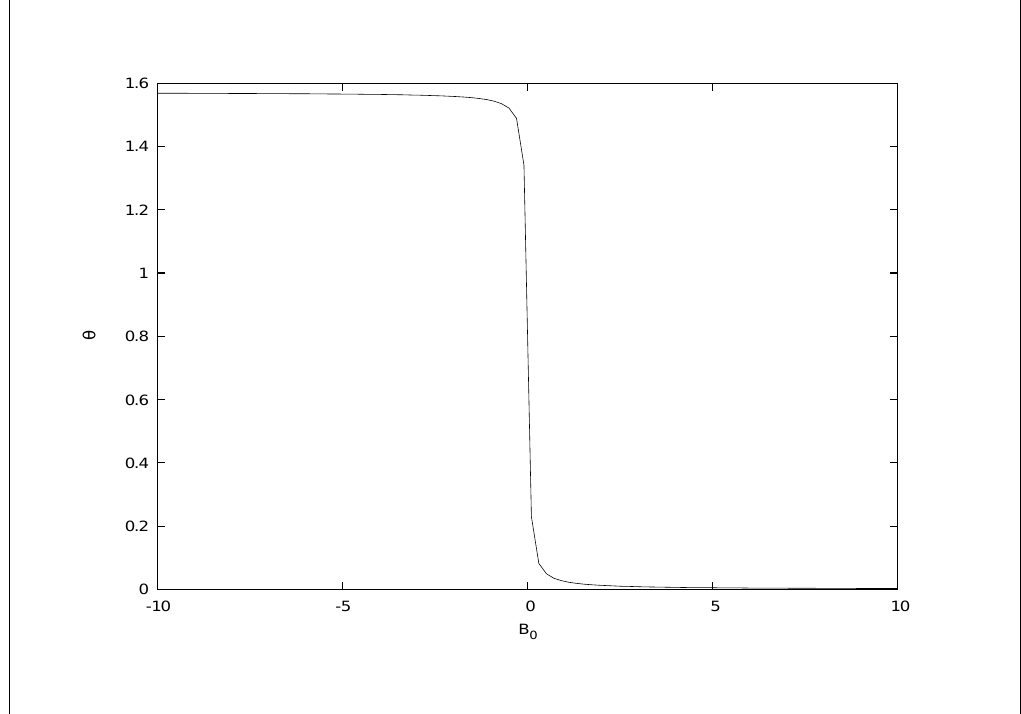
Figure 3. Variation of mixing angle in radian of basic neutrino–antineutrino mixing as a function of gravitational coupling in units of eV with m = 0.05 eV.